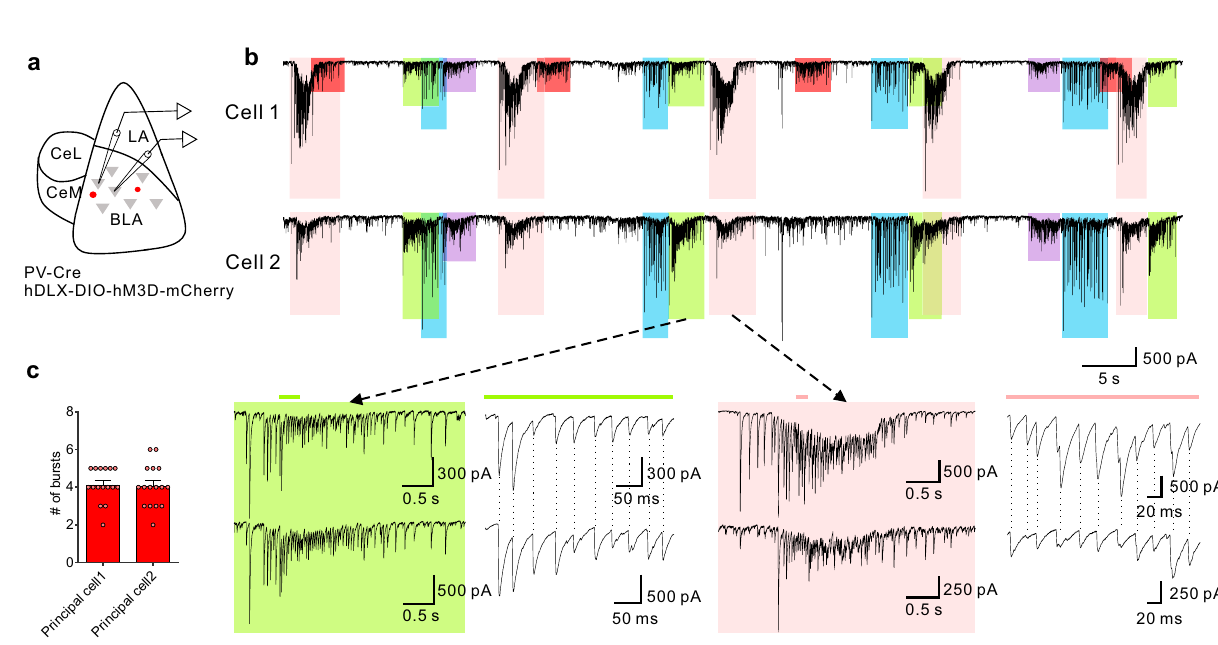
Fig. 2 Synchronized Gq-activated IPSC bursts in BLA principal neurons. a Schematic showing paradigm of paired recordings of adjacent BLA principal neurons in Gq-DREADD-injected PV-Cre mice. b Representative recordings showing synchronized bursts of IPSCs in a pair of BLA principal neurons, Cell 1 and Cell 2. Different colored boxes represent different IPSC bursts repeated over the course of the recording; the same-colored boxes in the two recordings indicate bursts that were synchronized between the two cells. The red-shaded bursts in cell 1 were not associated with a synchronous IPSC burst in cell 2. Bottom: Expanded traces of two different, color-coded IPSC bursts from each cell. Sections of the bursts were further expanded (indicated by the green and pink lines). The dotted vertical lines show the high synchronicity between the two cells of the individual IPSCs that make up each of the bursts. c The total number of different subtypes of bursts (mean ± SEM) induced in pairs of principal cells by Gq activation of PV interneurons (16 principal neuron pairs from 6 mice). Source data are provided as a Source Data fi